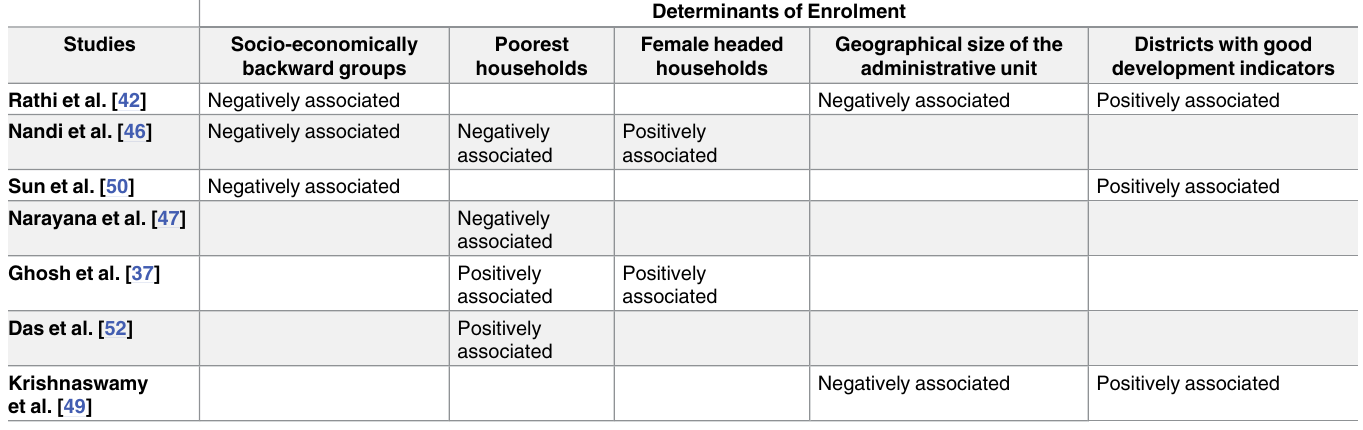
Table 5. Factors associated with enrolment in publicly financed insurance schemesin